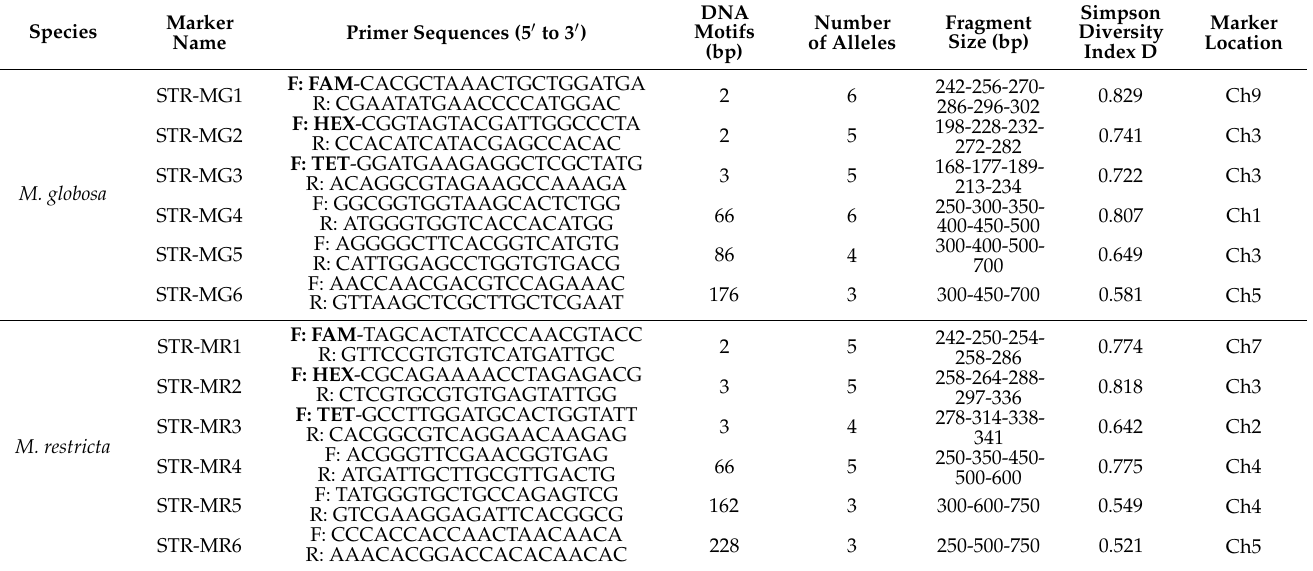
Table 1. Features of the polymorphic VNTR of M. globosa and M. restricta upon analysis of 68 isolates.